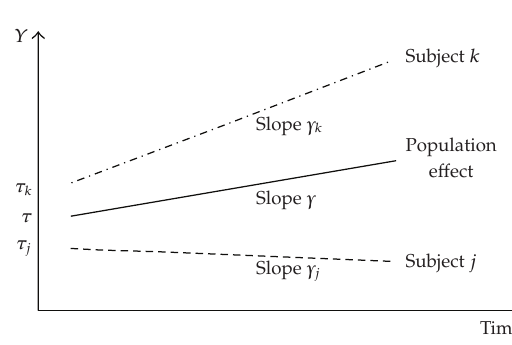
Figure 1: The random slopes